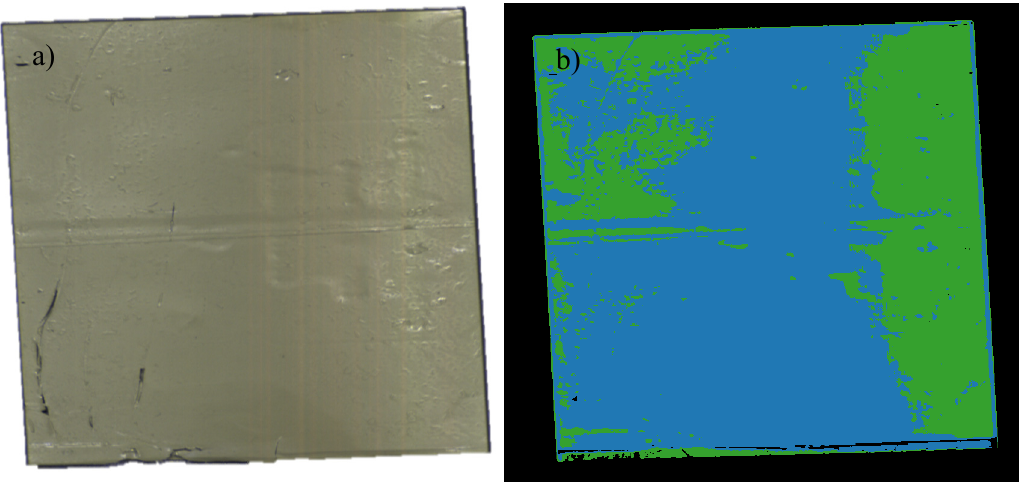
Figure 6. RGB ( a ) and corresponding colormap image ( b ) for UVA aged RTV-1 showing standard RTV-1 material (blue) and low molecular weight oil on the surface (green) HTV.